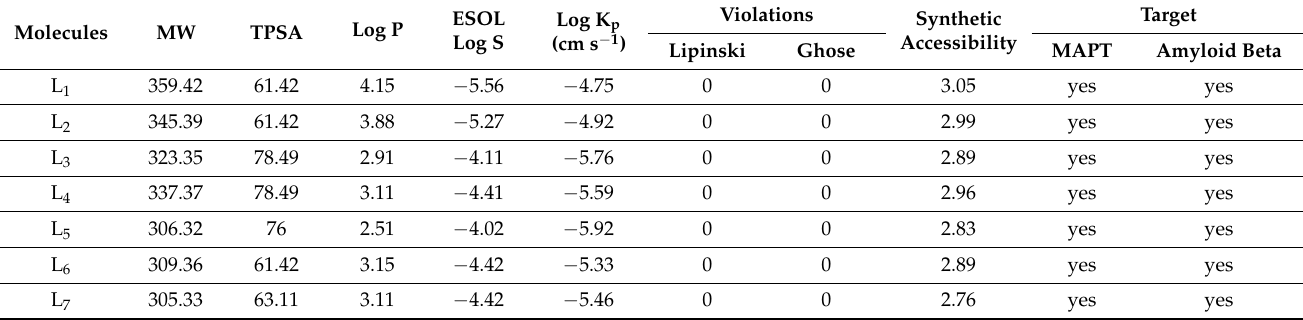
Table 1. In silico drug-likeness properties of L 1–7 obtained using the SwissADME tool.